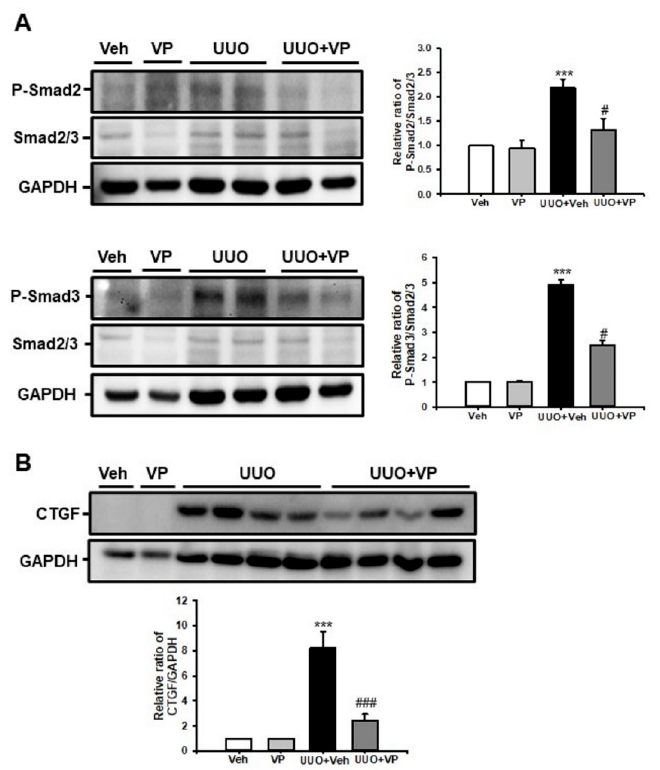
Figure 4. Effect of verteporfin on UUO-induced connective tissue growth factor expression through the regulation of Smad2 and Smad3 phosphorylation. ( A ) Phospho-Smad2 and phospho-Smad3 expression in kidney tissue from sham- and UUO-operated mice treated with vehicle (Veh) or verteporfin (VP) was evaluated by Western blotting. Data from the densitometric analysis of phospho-Smad2 and phospho-Smad3 are presented as the relative ratio of each protein to Smad2, Smad3, and GAPDH. The relative ratios measured in the kidneys of sham-operated mice treated with Veh are arbitrarily presented as 1. Data are expressed as the mean ± SD. *** p < 0.001 versus Veh or VP; # p < 0.05 versus UUO. ( B ) CTGF expression in kidney tissue from sham- and UUO-operated mice treated with Veh or VP was evaluated by Western blotting. Data from the densitometric analysis are presented as the relative ratio of each protein to GAPDH. The relative ratios measured in the kidneys of sham-operated mice treated with Veh are arbitrarily presented as 1. Data are expressed as the mean ± SD. *** p < 0.001 versus Veh or VP; ### p < 0.001 versus UUO; P-Smad, phospho-Smad; CTGF, connective tissue growth factor; Veh, vehicle; VP, verteporfin; UUO, unilateral ureteral obstruction operated mice, GAPDH, glyceraldehyde 3-phosphate dehydrogenase.